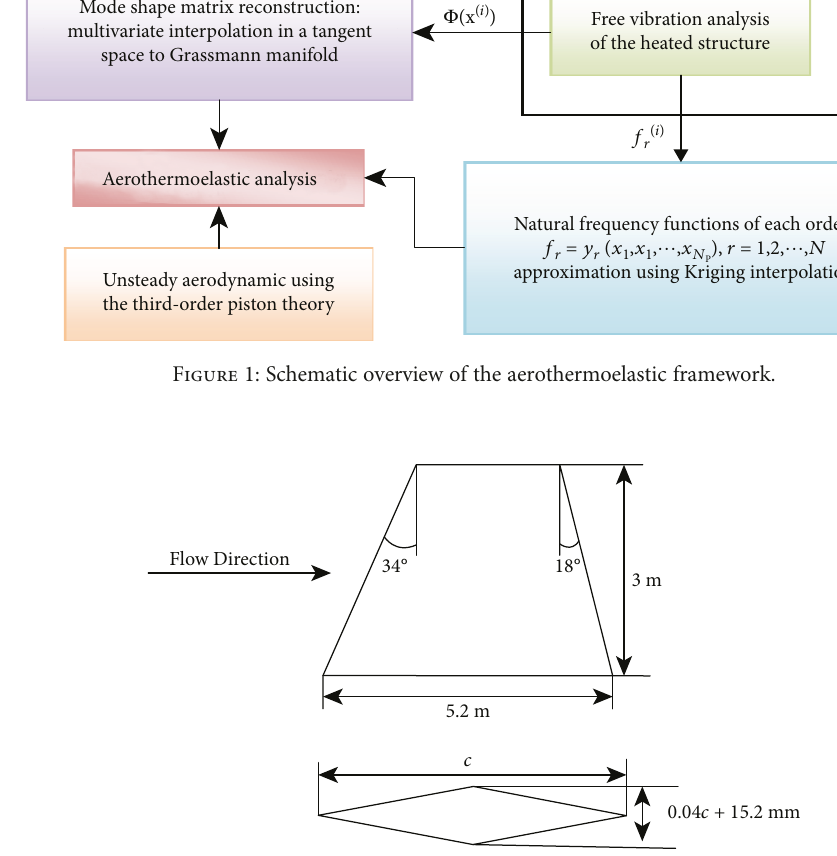
Figure 2: Geometric model of the control surface.